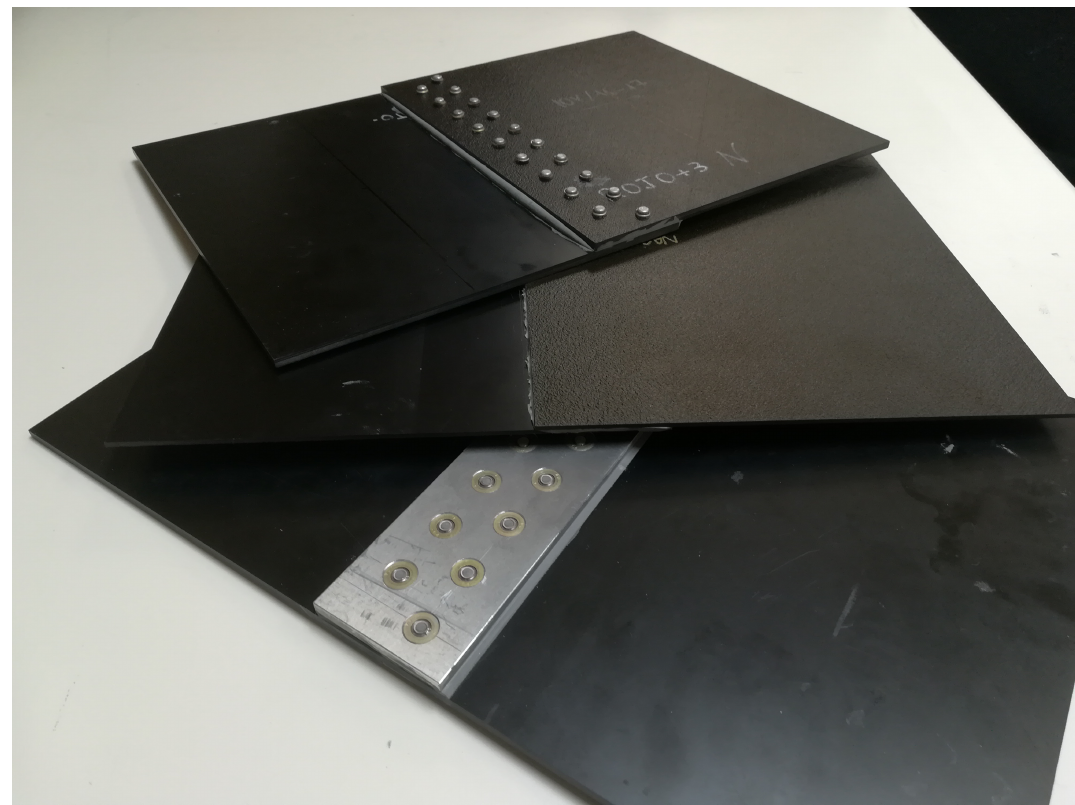
Figure 2. Carbon fiber composite (CFC) joints of the MILANO remotely piloted aircraft system (RPAS) structure. Top: material–rivets–material; middle: material–material; and bottom: